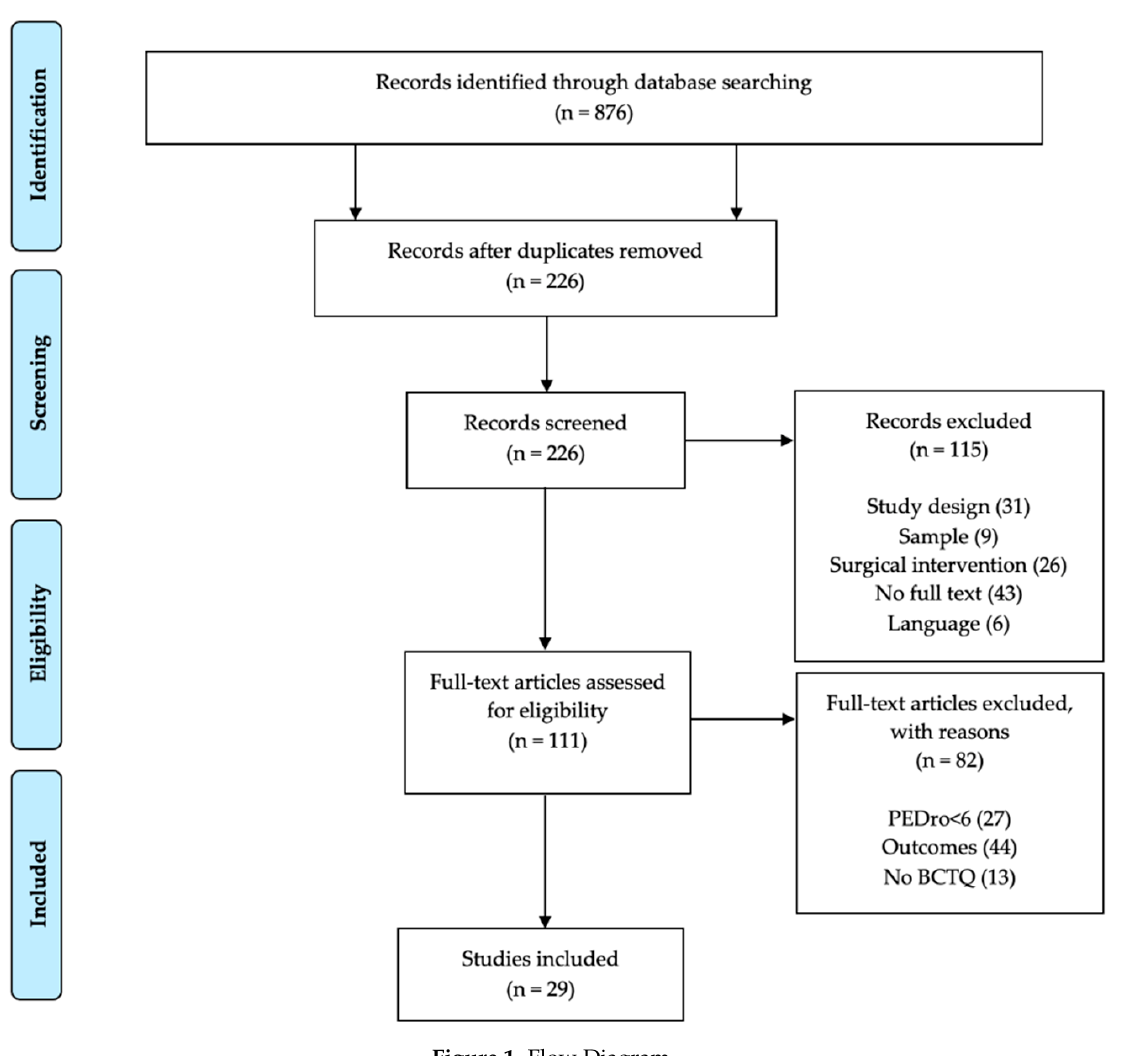
Figure 1. Flow Diagram.